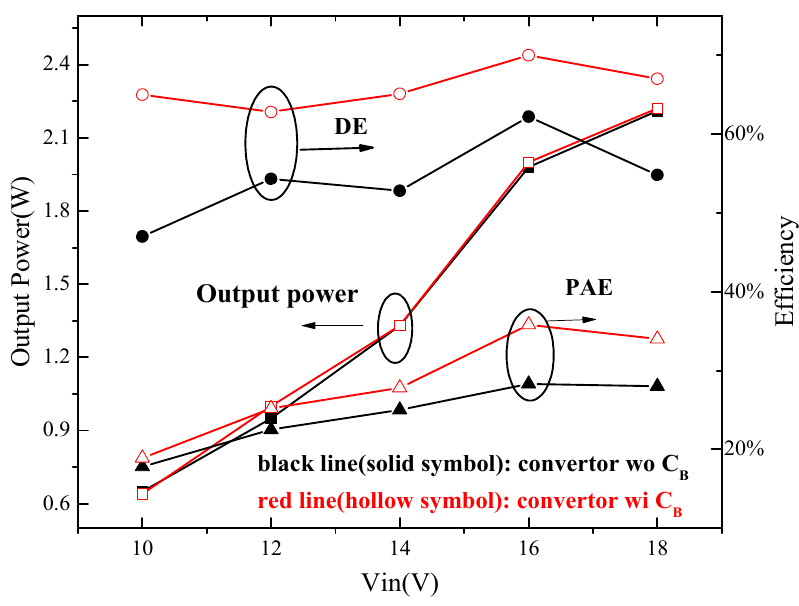
Figure 12. Measured efficiency and output power with differential.